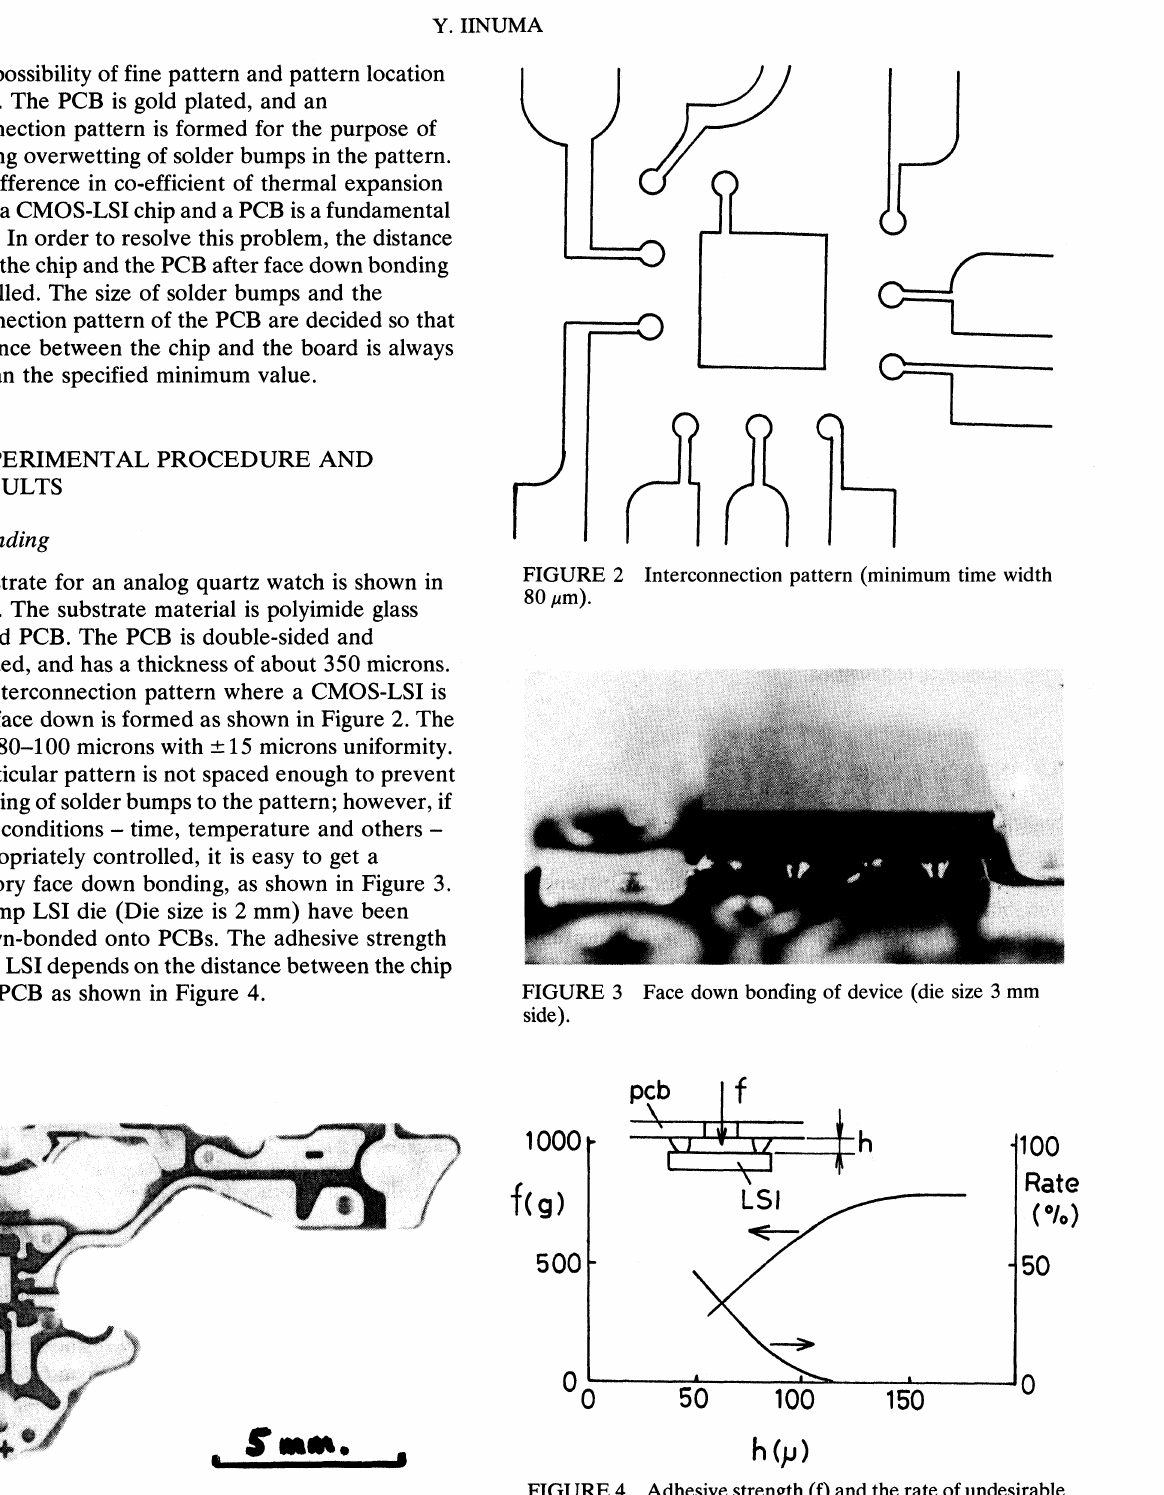
FIGURE 1 PCB for analog quartz watch.